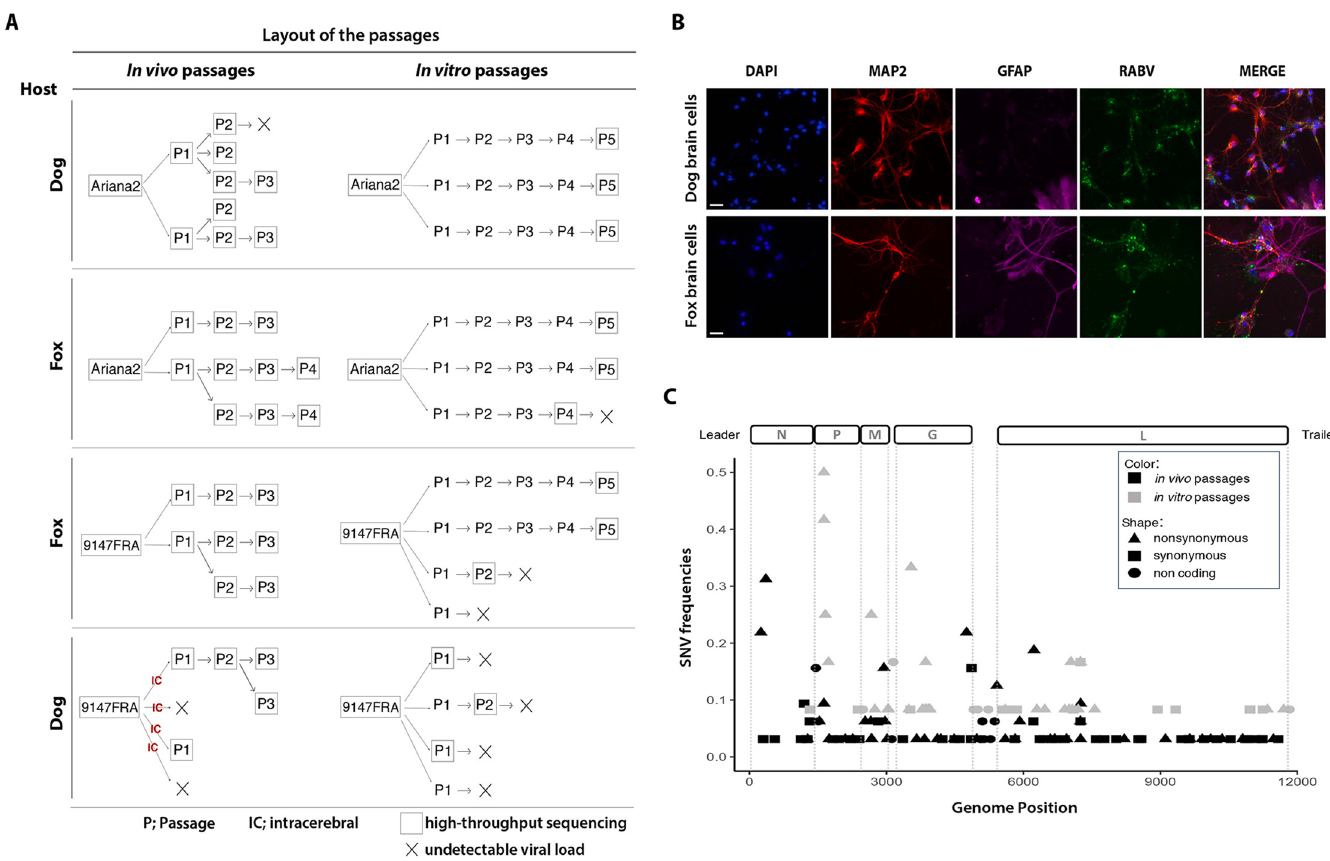
Fig 1. Genetic variability after experimental passages of RABV in vitro and in vivo . (A) Layout of the passage experiments. For the in vivo experiment, RABV was inoculated by intramuscular injection, with the exception of the first ‘vFox on Dog’ passages that were performed by intracerebral inoculation (IC). Viruses were isolated on each animal both from salivary gland and brain, titrated by qPCR and by intracerebral inoculation and sequenced. Virus isolated from salivary gland was used as inoculum for the subsequent animal passage. For the in vitro experiment, all passages were titrated to control the infectivity and only the last one was sequenced. The black cross illustrates passages that have been stopped because of the inability to obtain a enough high viral titer. (B) Images of dog and fox primary brain cell cultures infected with RABV (vfox 9147FRA and vdog Ariana2). Neuronal cells and astrocytes were stained with anti-MAP2 and anti-GFAP antibodies, respectively. Images were obtained using a Zeiss Axioplan fluorescence microscope equipped with a Zeiss ApoTome system (obj.10X). Bars = 50 μ m. (C) RABV intrinsic variability characterized by high-throughput sequencing. A schematic representation of RABV genome is shown at the top of the figure. ORFs are delimited by dotted grey lines. Frequencies of RABV Single Nucleotide Variations (SNVs), after in vivo (in black) or in vitro (in gray) experimental passages, are graphically represented along the genome. Different types of SNVs detected; nonsynonymous, synonymous or non-coding, are characterized by different shapes. An arbitrary cut-off frequency of 2% was used to validate variants as significantly different from artefactually introduced reverse-transcription, PCR and sequencing errors. Abbreviations: vDog—Ariana2 strain; vFox - 9147FRA strain.